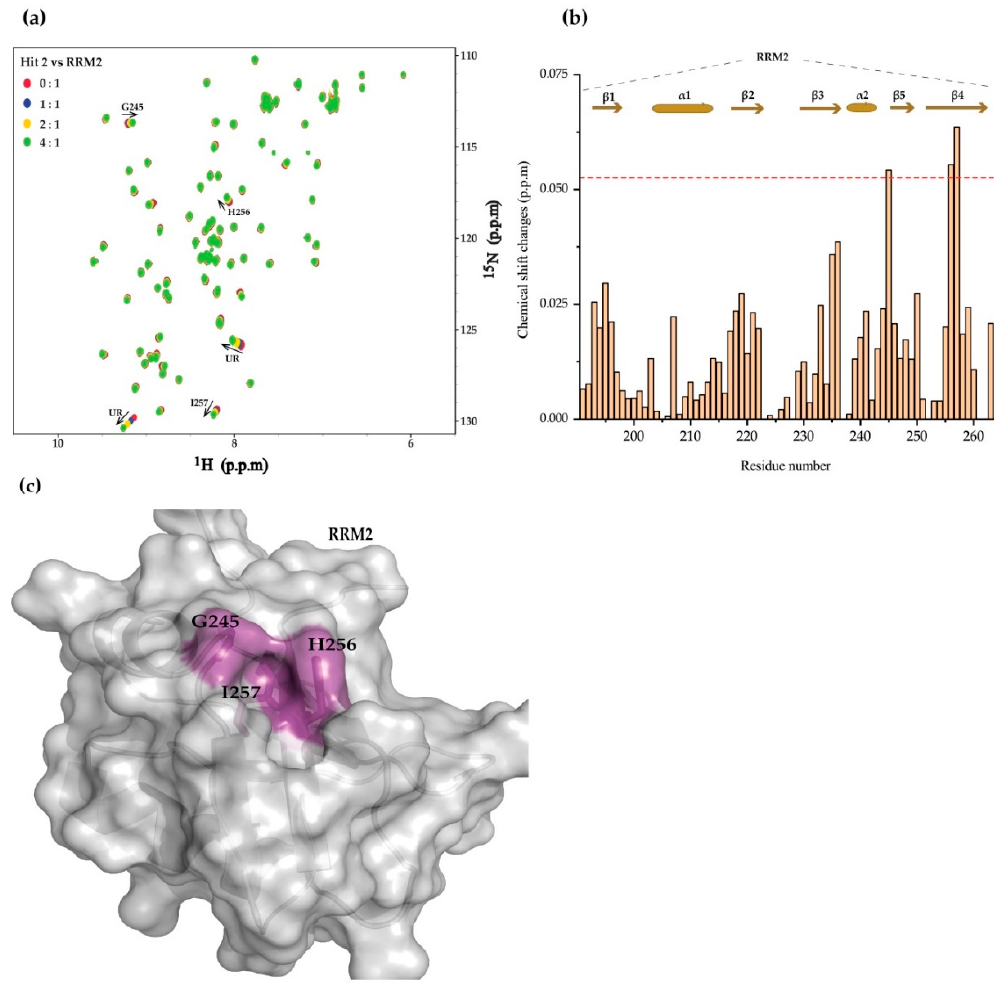
Figure 4. Chemical shift perturbations of the TDP-43-RRM2 domain upon hit 2 titration. ( a ) The chemical shift perturbations of the RRM2 domain of TDP-43 by hit 2 titration. ( b ) Chemical shift changes of the TDP-43 RRM2 domain residues at a hit 2; protein molar ratio of 4:1. The red dashed line represents two standard deviations above the averaged chemical shift changes of residues. ( c ) Residues (colored in purple) undergo significant chemical shift changes and are mapped on the surface representation of TDP-43-RRM2 domain (PDB code: 1WF0).